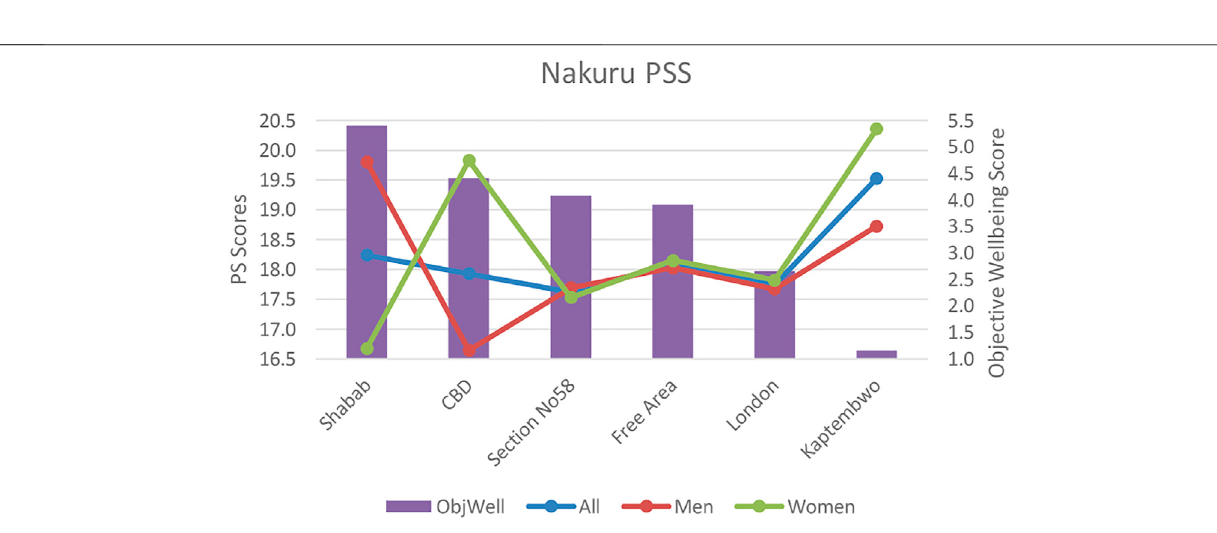
Frontiers in Sociology |